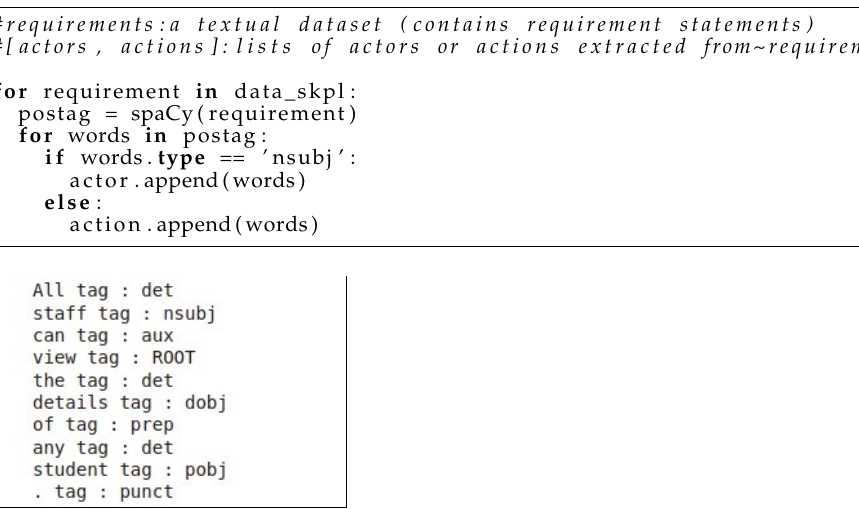
Figure 2. Results of syntactic dependency parsing using the SpaCy